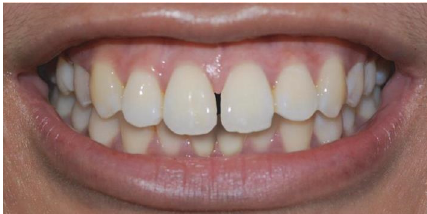
F IGURE 2: Photograph of digitally manipulated 0.5mm maxillary midline diastema.